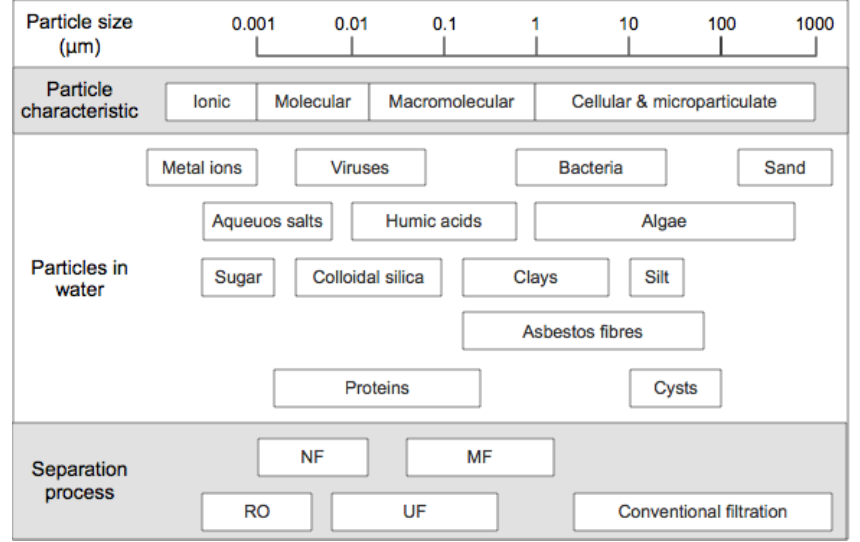
Figure 1. Typical membrane processes and applications (adapted from